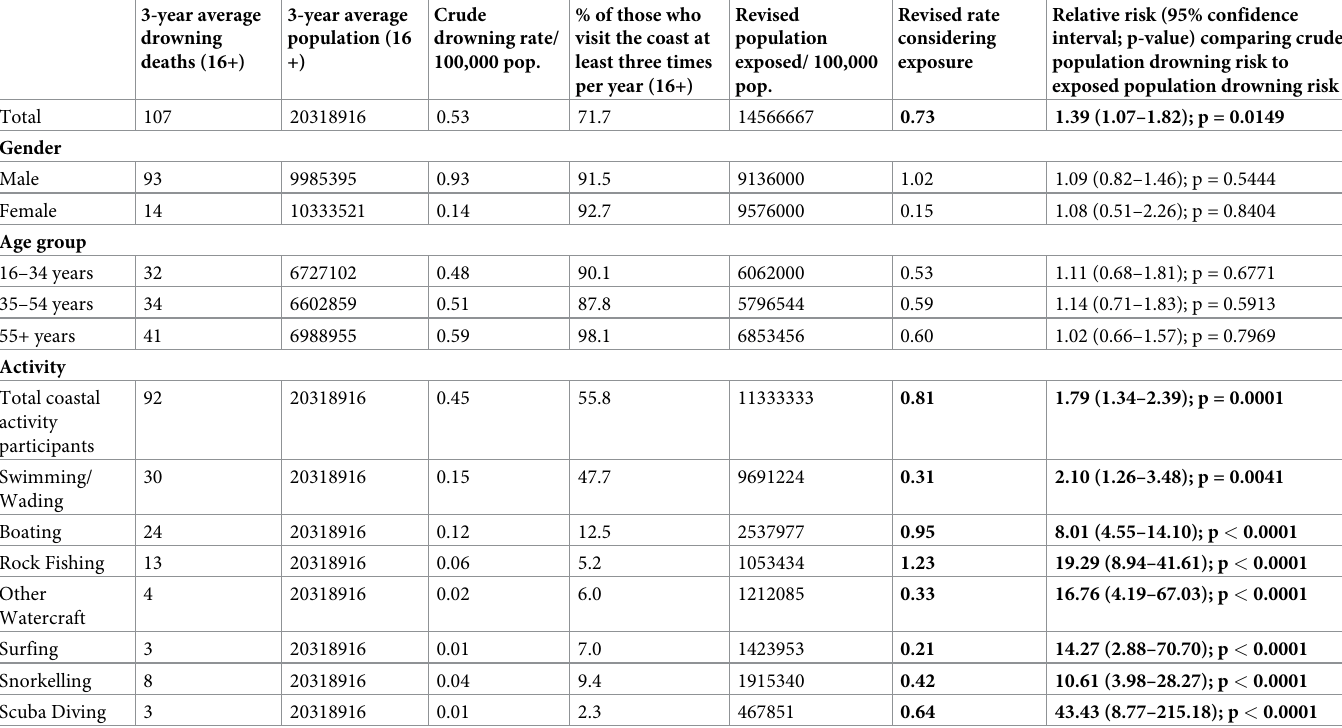
Table 4. Preliminary estimates of fatal unintentional drowning rates for dominant coastal activities, with and without exposure using data collated for decedents aged 16 years and above (calculated for reporting periods 2017/18FY-2019/20FY). Bold type indicates